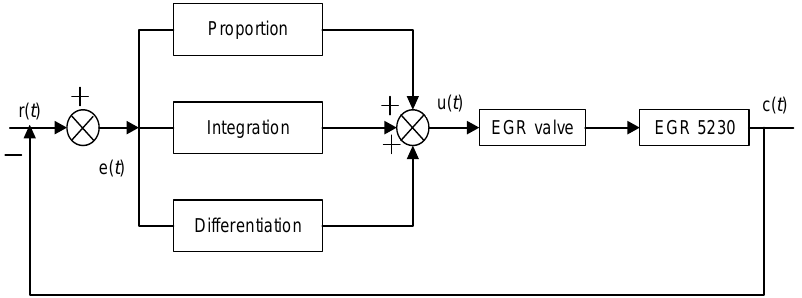
Figure 4. The PID control program of exhaust gas recirculation (EGR) value. PID: proportion, integration, differentiation.